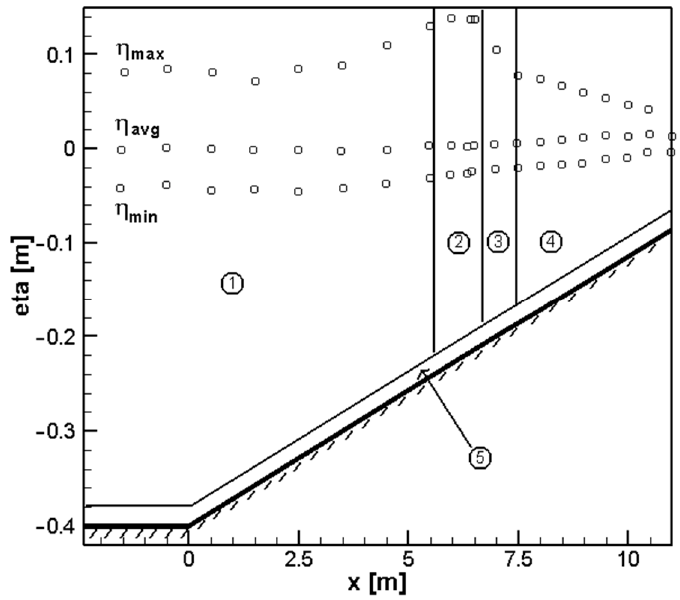
Figure 1. Maximum, averaged and minimum water surface elevations. Definitions of the zones.